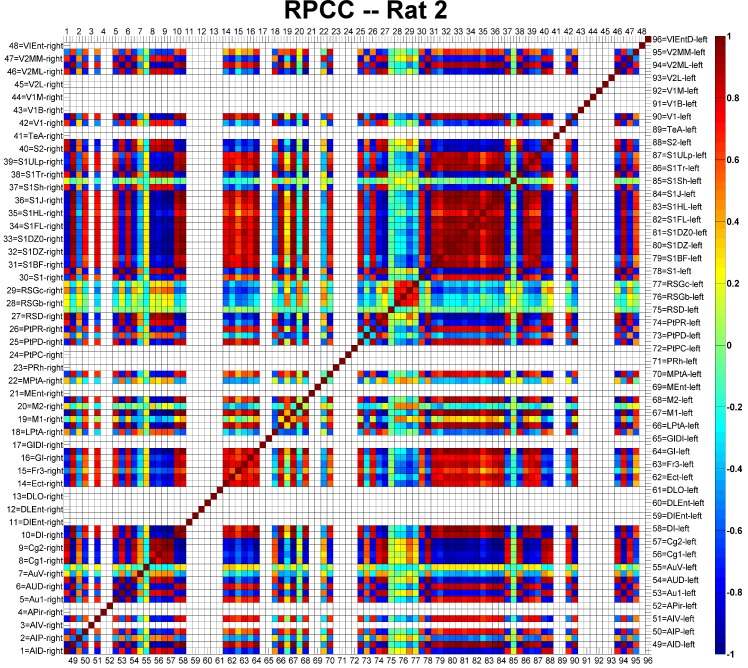
Example of the regional pairwise correlation coefficient (RPCC) map of the averaged resting-state time series in the cortical regions of Rat 2.Numbers 1–48 represent cortical regions on the right hemisphere and numbers 49–96 represent cortical regions on the left hemisphere. The abbreviations of the cortical regions are defined by Paxions et al. [45]. Areas not covered by the echo planar imaging acquisitions are left blank. The color-bar represents the RPCC value; dark red indicates strong correlation (r>0.8) and deep blue strong anti-correlation (r<-0.8).